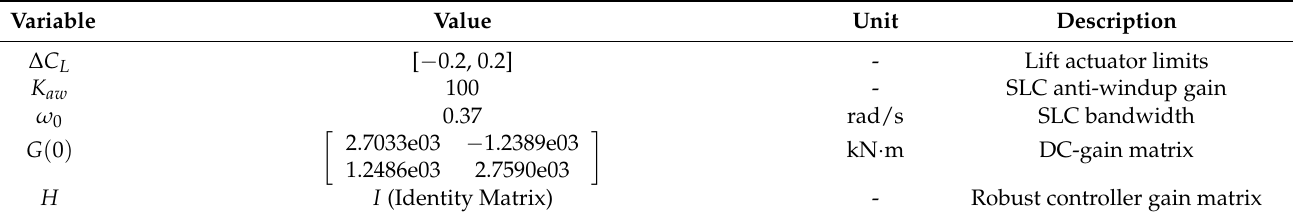
Table A2. SLC controller parameters from [9].